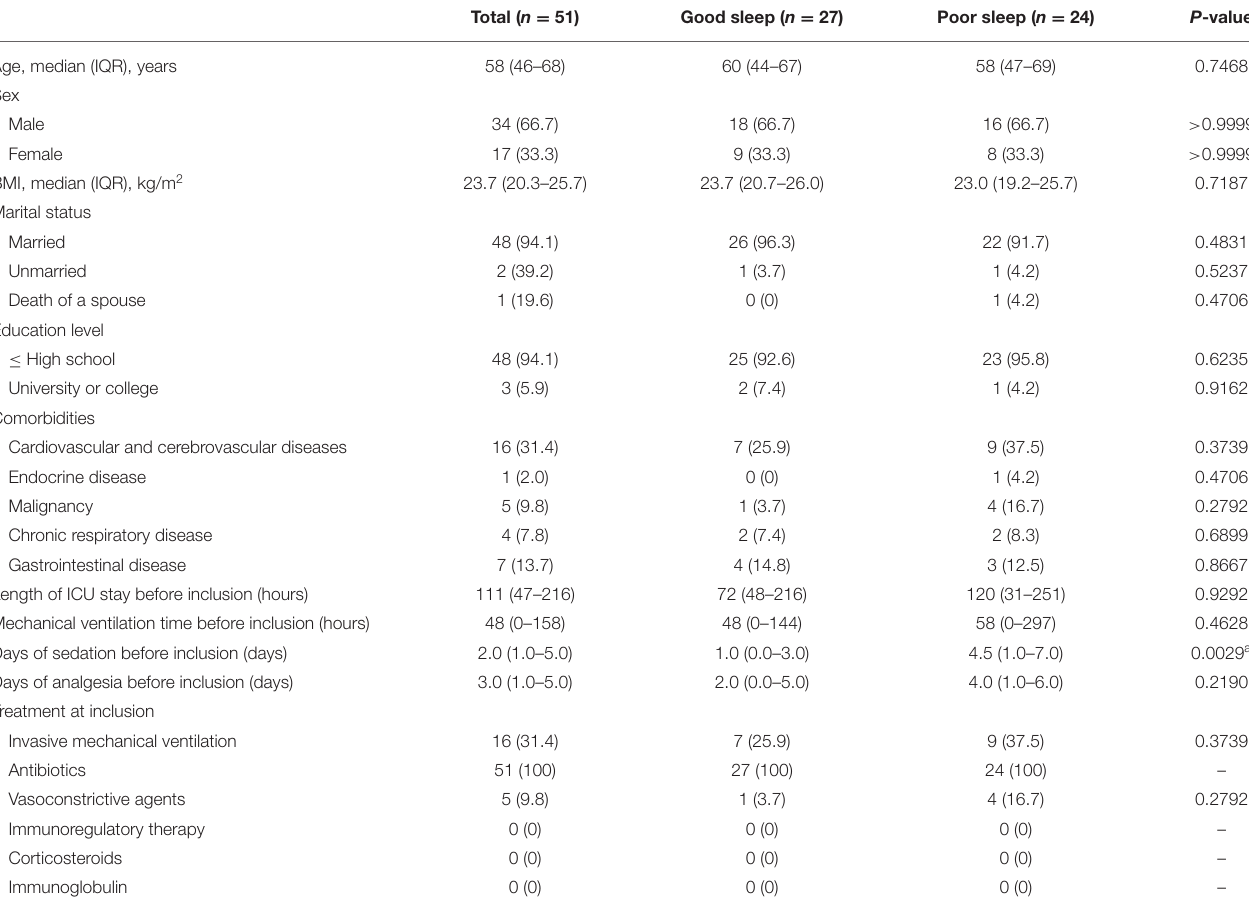
TABLE 2 | Demographics and baseline characteristics of septic